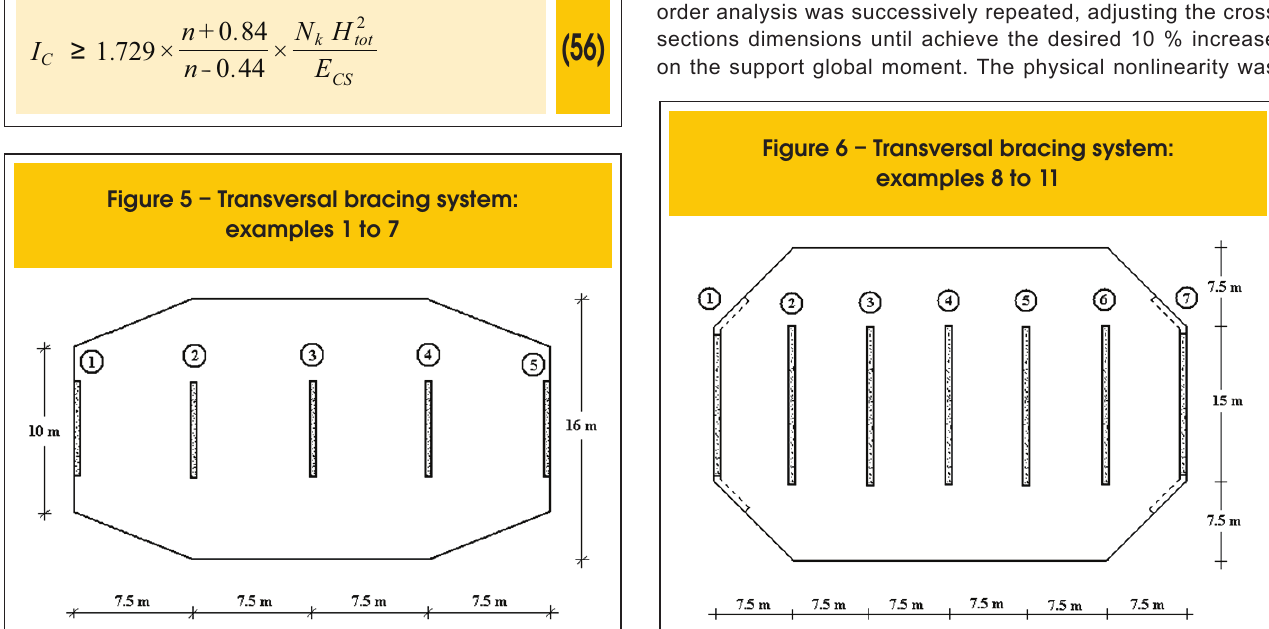
Figure 5 – Transversal bracing system: examples 1 to 7